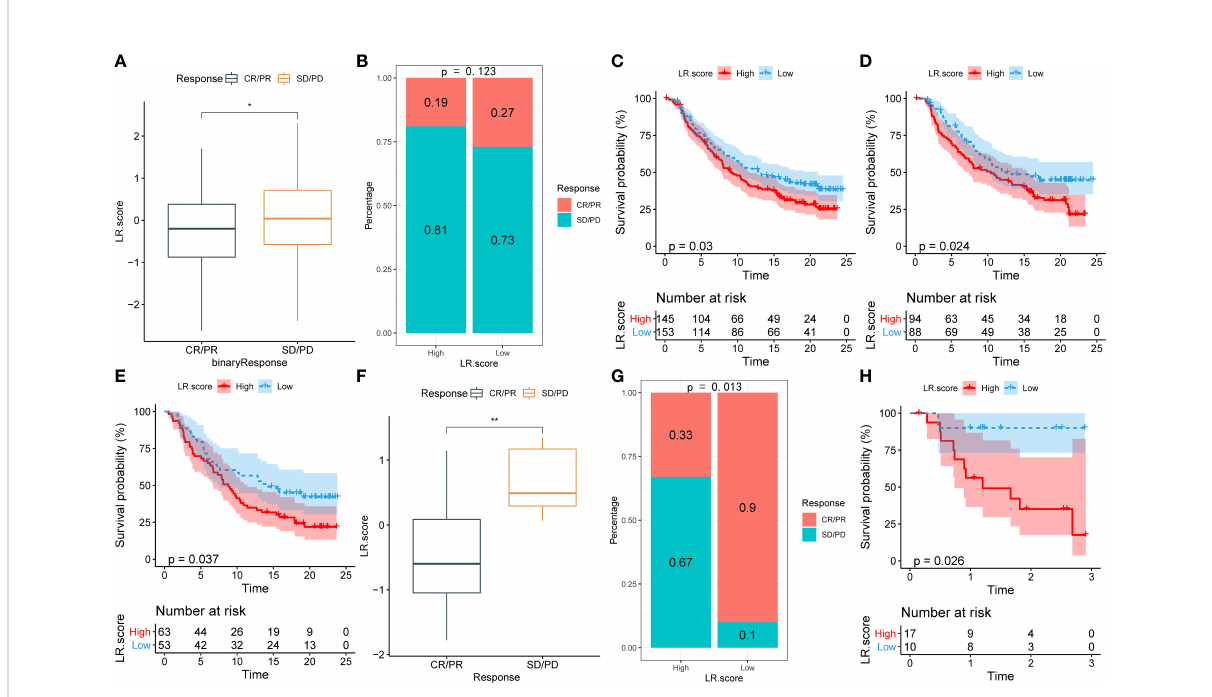
FIGURE 11 (A) Differences in LR.score between immunotherapy response groups in IMvigor210 cohort. (B) Differences in immunotherapy response between LR.score groups in IMvigor210 cohort. (C) Prognostic difference between LR.score groups in IMvigor210 cohort. (D) Prognostic difference between LR.score groups of early-stage patients in IMvigor210 cohort. (E) Prognostic difference between LR.score groups of late- stage patients in IMvigor210 cohort. (F) Differences in LR.score between immunotherapy response groups in GSE78220 cohort. (G) Differences in immunotherapy response between LR.score groups in GSE78220 cohort. (H) Prognostic difference between LR.score groups in GSE78220